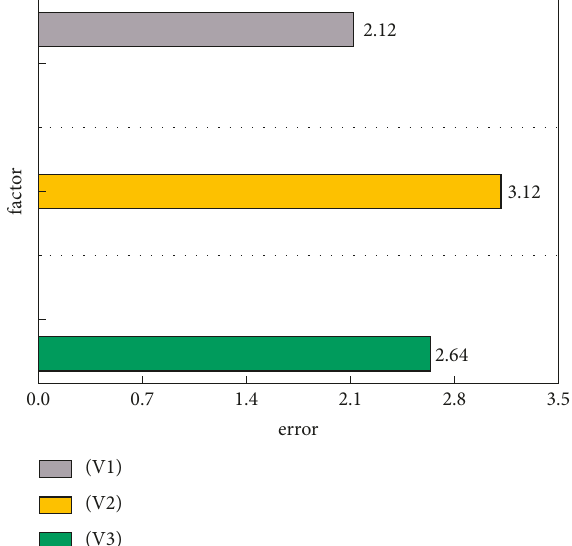
Figure 4: The prediction errors of self-media technical content and traditional path-related features using a single atrous convolution.